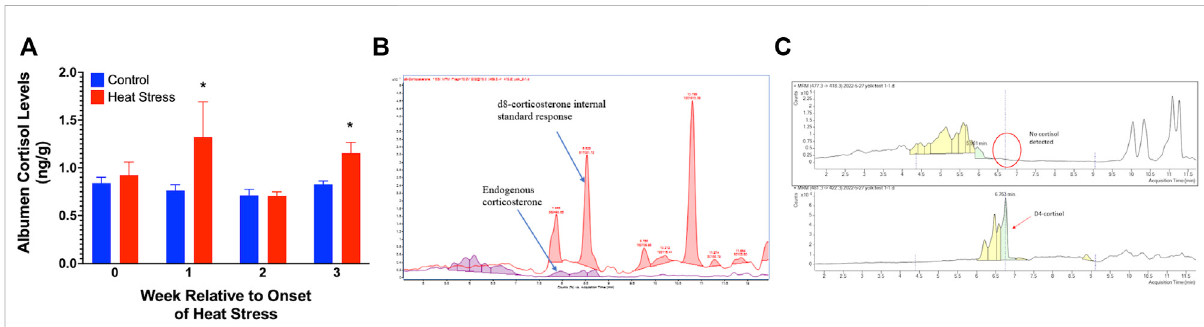
FIGURE 5 Egg albumen concentration ofcortisol (A) , Chromatographoverlay for yolk corticosteronecomparison (B) , and yolkcortisolcomparison (C) of ducks exposed to cyclic heat stress (35 ° C for 10h/day and 29.5 ° C for the remaining 14h/day) or control. Data shown for Figure 5A are means ± SEM, n = 6/treatment/week. Albumen cortisol levels were signi fi cantly increased at weeks 1 and 3 after onset of treatment compared to controls. The endogenous corticosterone in the samples were below detectable limits. Cortisol and corticosterone were not detected in yolk samples. * = p <